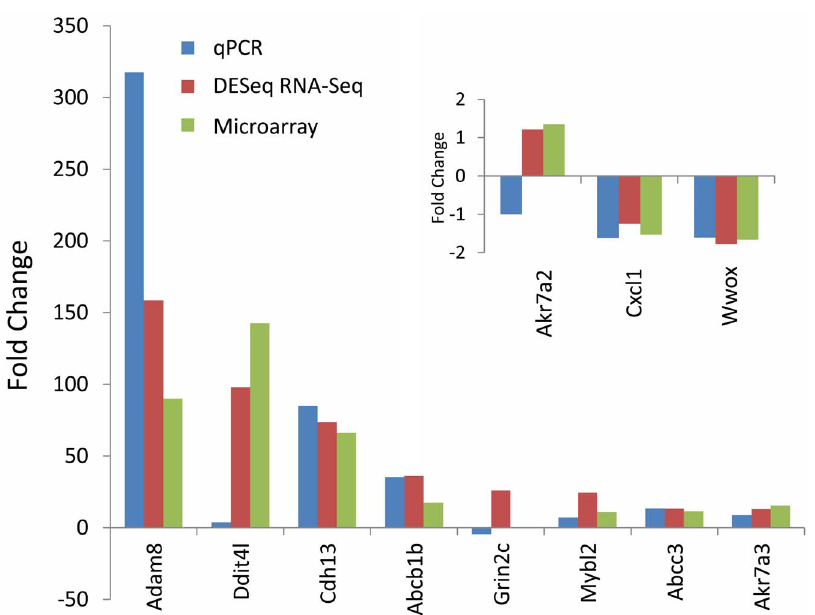
Figure 2. Test and validation of differential expression between qPCR, RNA-Seq and microarray by select transcripts. The mean fold changes for each group were compared in the bar chart for eight high to medium fold change transcripts and three low expression change transcripts (inset). qPCR data were normalized to b -actin expression for each sample. Means of significant (p # 0.05) fold changes from control were computed for qPCR, DESeq and microarray using RNA from the same 4 animals in each